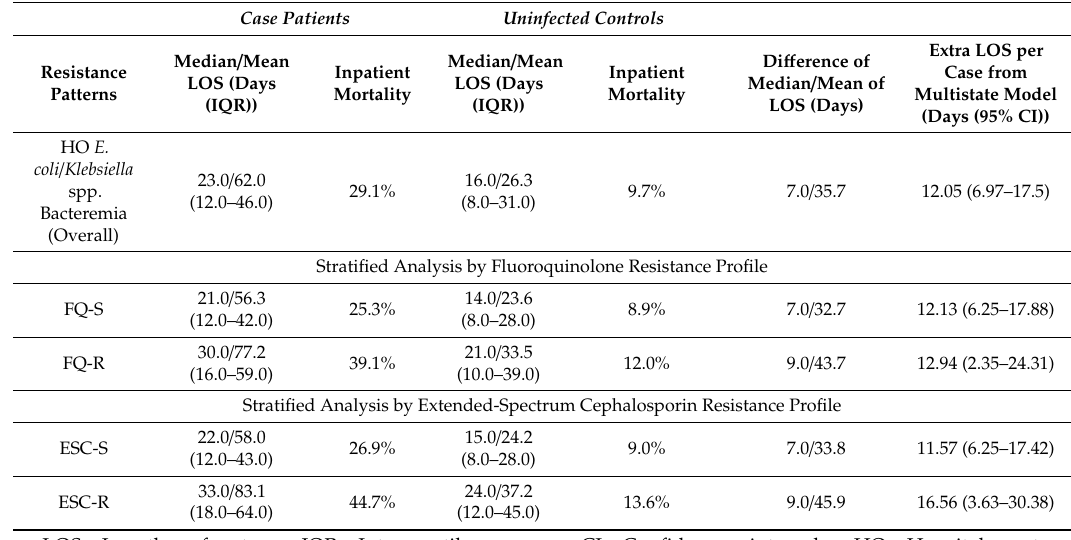
Table 2. Excess length of stay caused by hospital-onset Escherichia coli / Klebsiella spp. bacteremia, stratified by the presence / absence of resistance patterns.